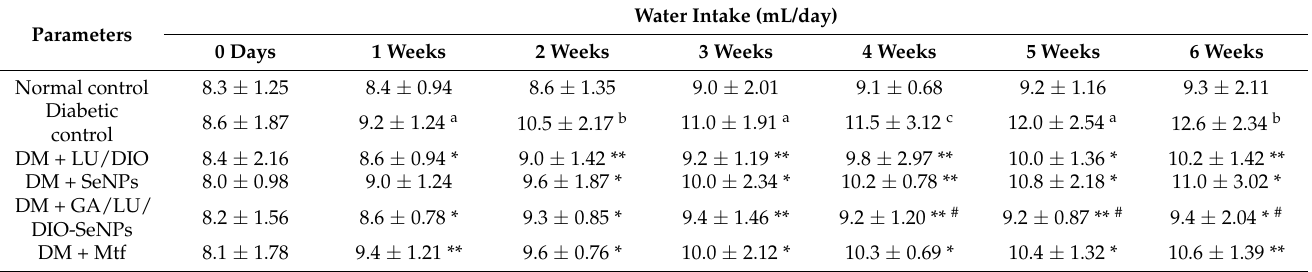
Table 2. Effect of flavonoid formulation (LU/DIO), SeNPs, and GA/LU/DIO-SeNPs on water intake in diabetic mice.